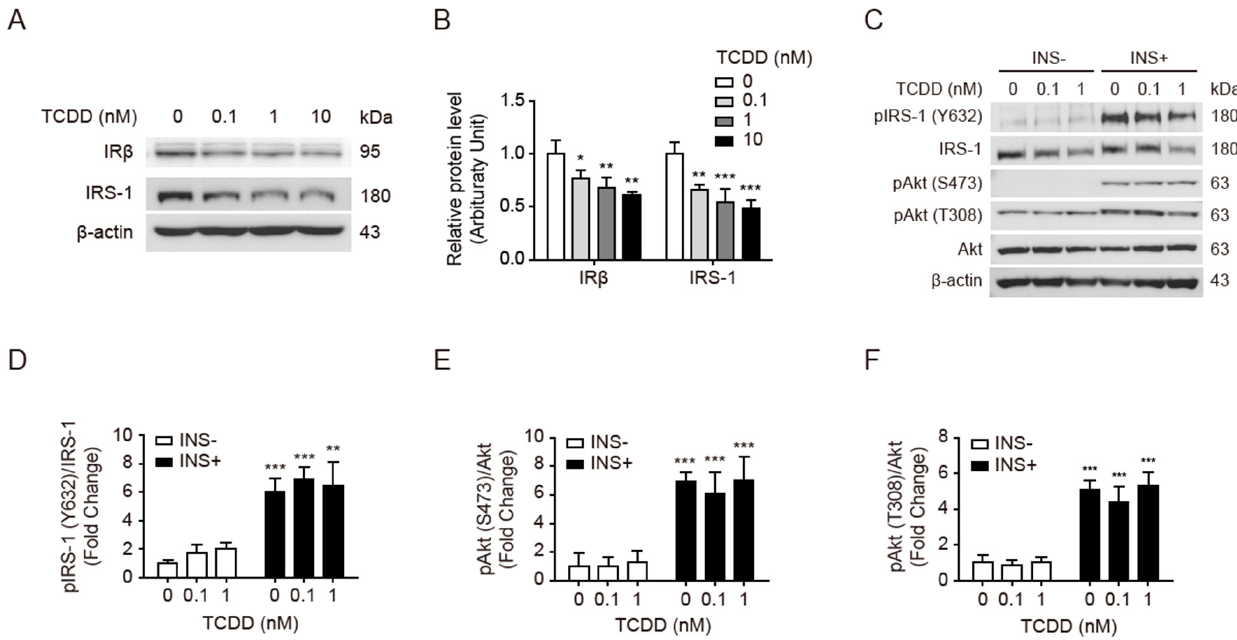
Figure 2. TCDD downregulated IR β and IRS-1 protein expression without reducing Akt phosphorylation. C2C12 myoblasts were treated with TCDD (0, 0.1, 1, or 10 nM) for 48 h with or without stimulation with 100 nM of insulin (INS+) for 15 min. ( A,C ) Western blot of insulin signaling proteins. TCDD-treated C2C12 cell lysates were separated on 10% SDS-PAGE and detected with the indicated antibodies; β -actin is a loading control. ( B ) Quantification of band intensities of Western blot of panel A. ( D – F ) Quantification of band intensities of Western blot of panel C. The ratios of pIRS-1 and pAkt to IRS-1 and Akt are presented as fold changes relative to the DMSO-treated control. Data are presented as means ± SEM ( n = 4). Note: * p < 0.05, ** p < 0.01, *** p < 0.001 vs. DMSO or INS-control.